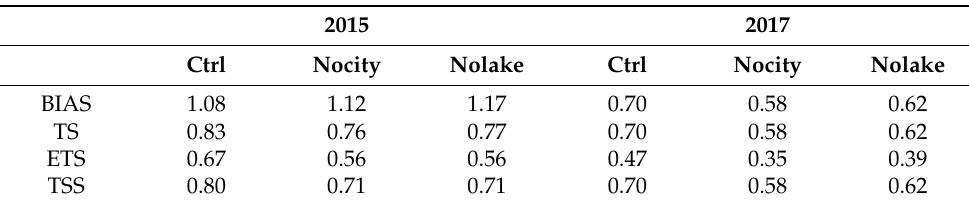
Table 2. The skill scores of torrential rain ( ≥ 50 mm) in the control, Nocity, and Nolake runs for two events.